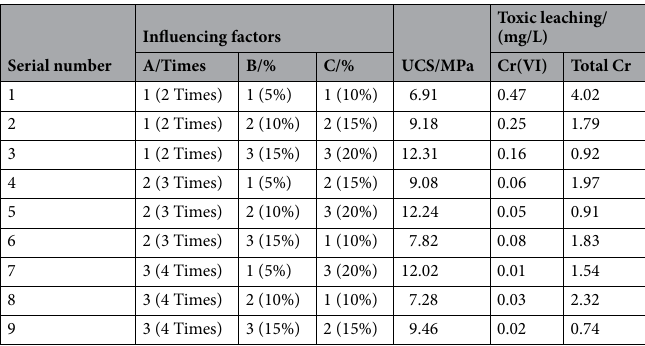
Table 1. Orthogonal design scheme and results.